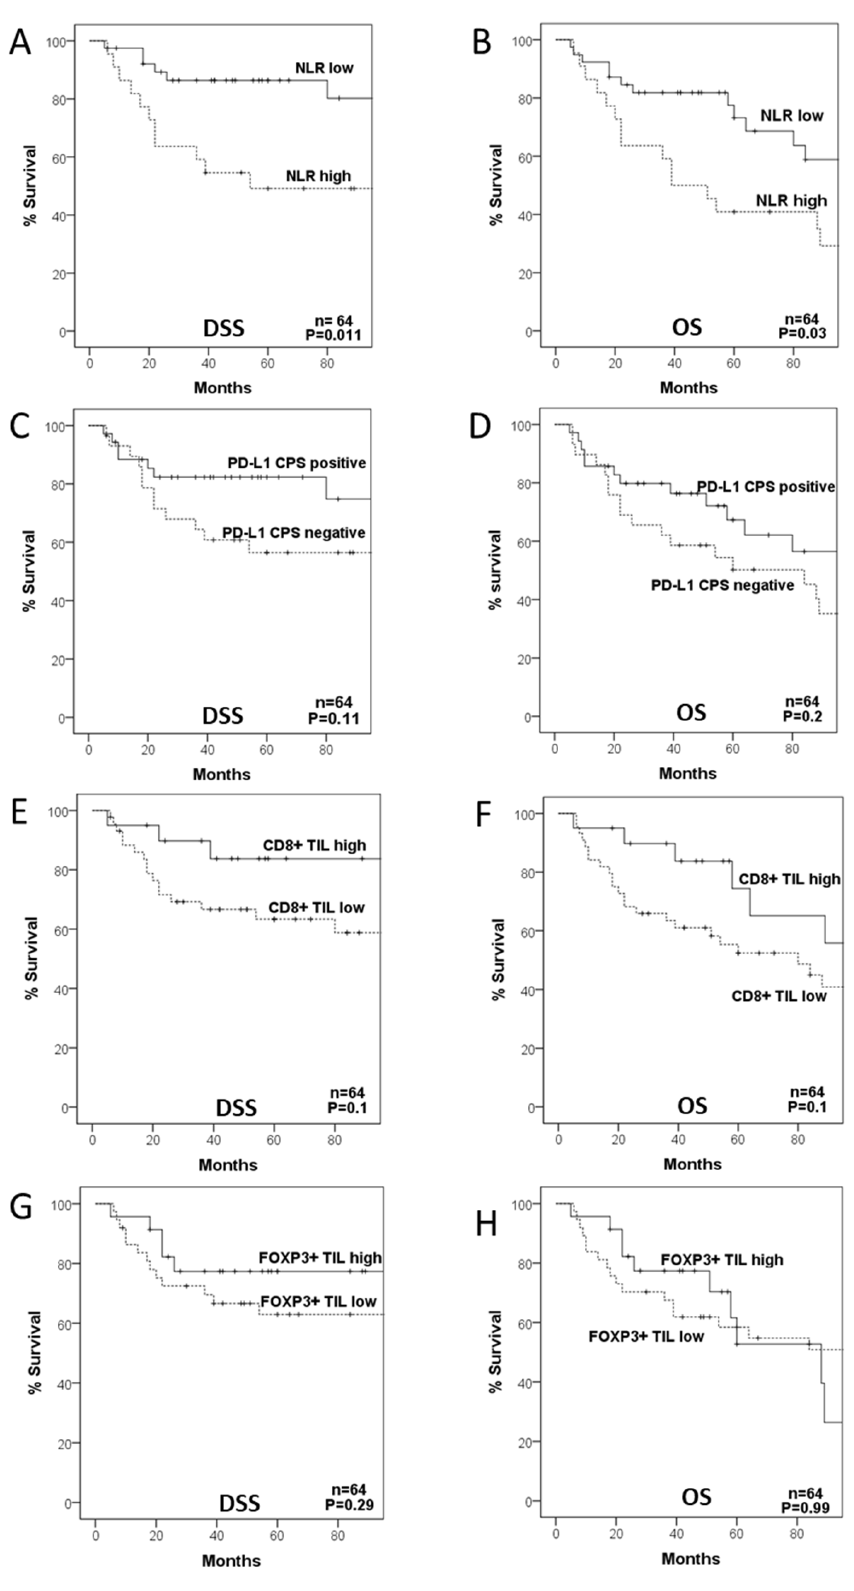
Figure 2. Disease-specific (DSS) and overall survival (OS) curves categorized according to neutrophil-to-lymphocyte ratio (NLR ( A , B )), PD-L1 composite proportion score (CPS ( C , D )), CD8+ TIL density ( E , F ), and FOXP3+ TIL density ( G , H ).